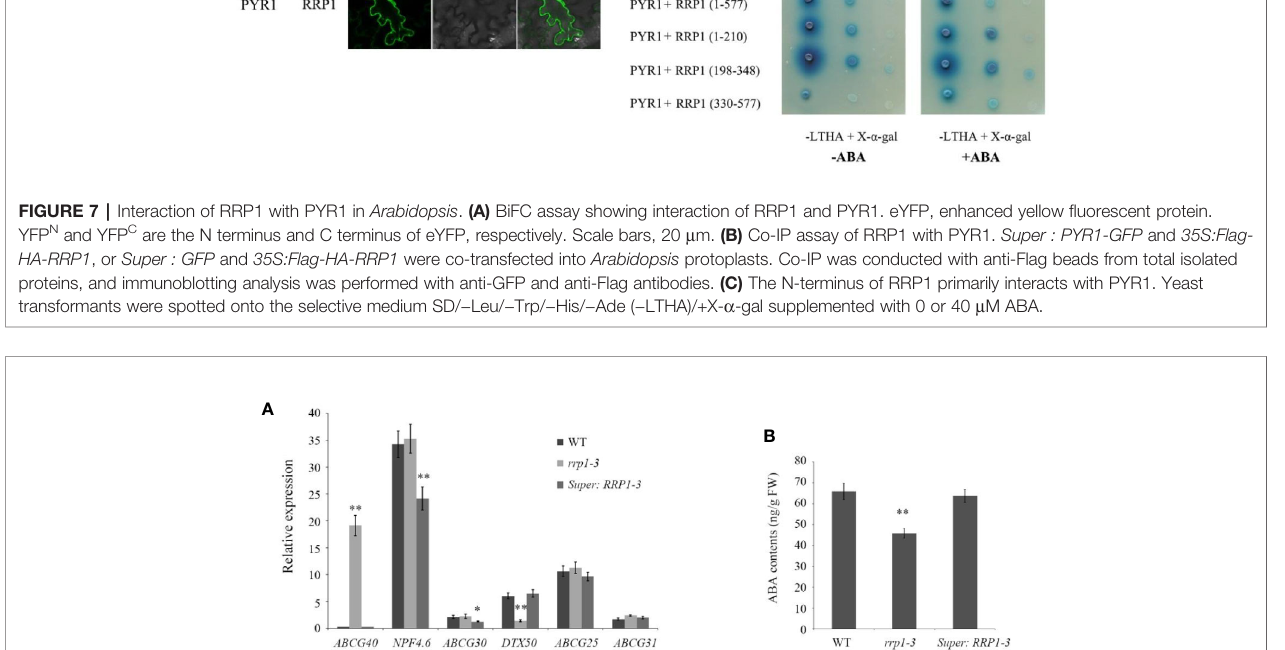
FIGURE 8 | Analysis of relative expression levels of ABA transporter genes and ABA contents intransgenic Arabidopsis plants. (A) Transcripts of a set of ABA transporter genes were analyzed by quantitative real-time PCR in the wild-type, rrp1-3 , and Super : RRP1-3 plants. (B) ABA contents in the wild-type, rrp1-3 , and Super : RRP1-3 plants. The data represent the mean ± SE ( n = 3). Asterisks indicate statistically signi fi cant differences compared with wild-type plants: *, P < 0.05; **, P < 0.01.